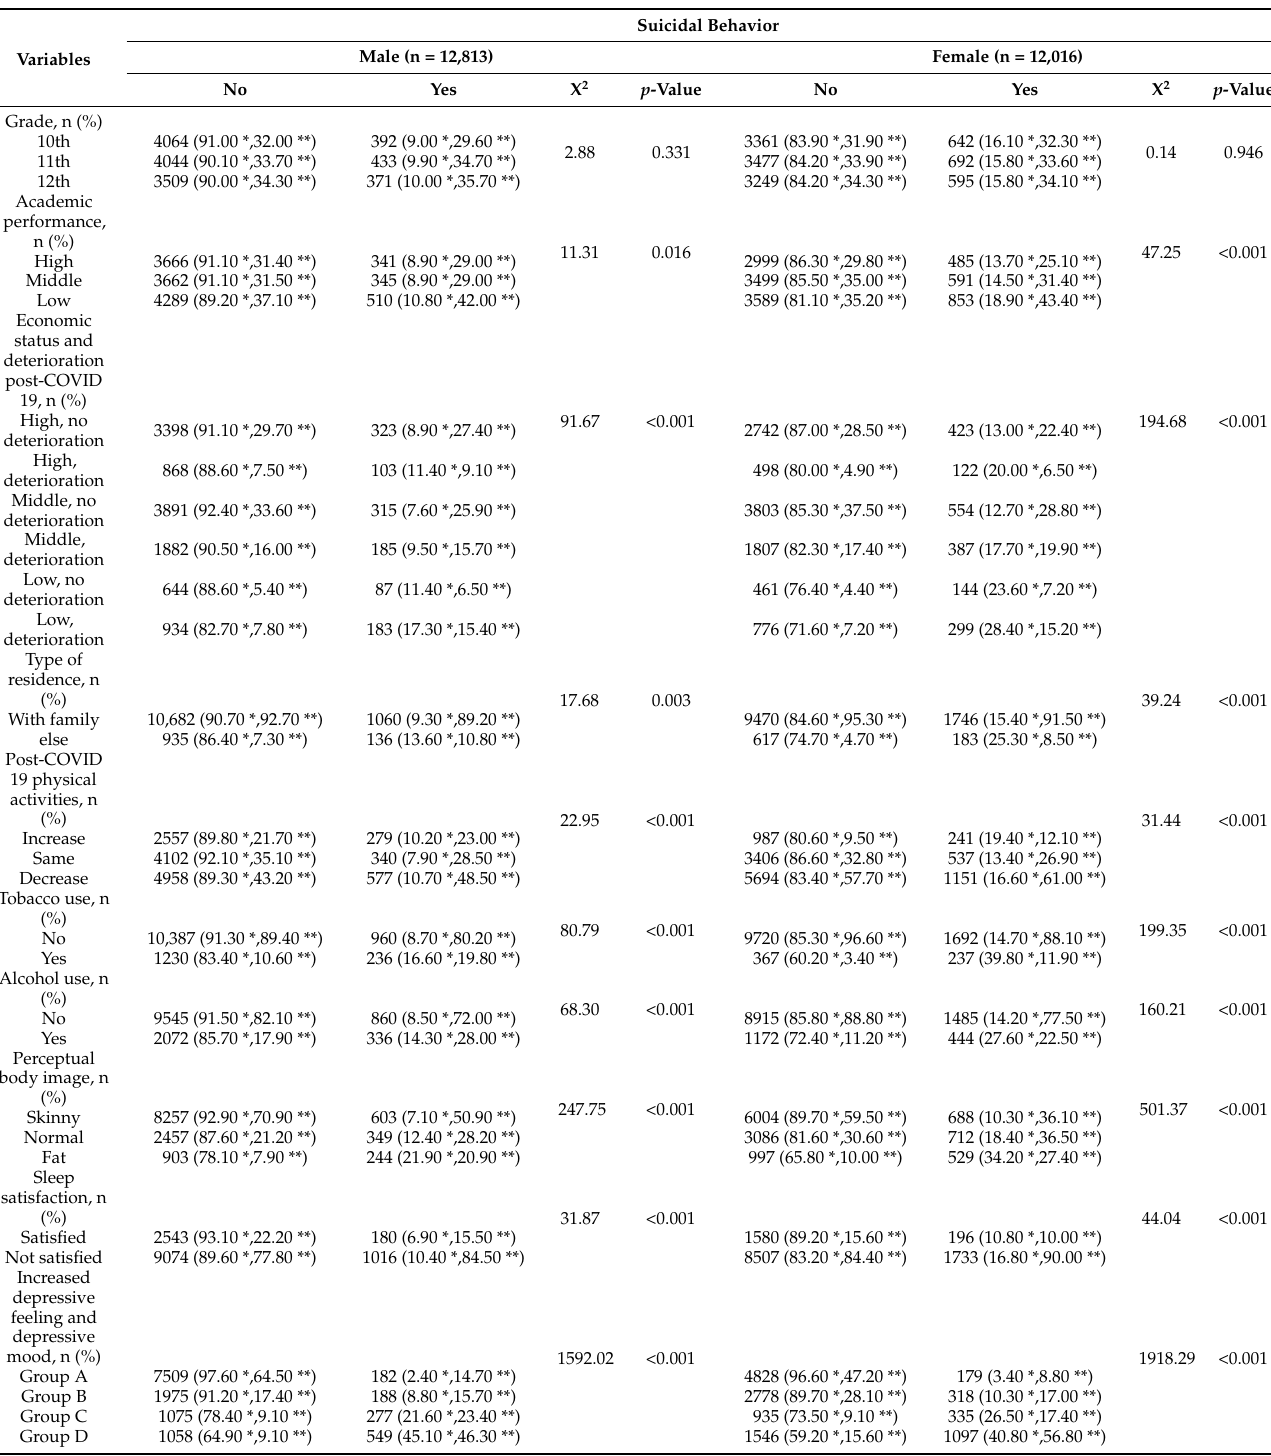
Table 1. Sociodemographic characteristics of participants and suicidal